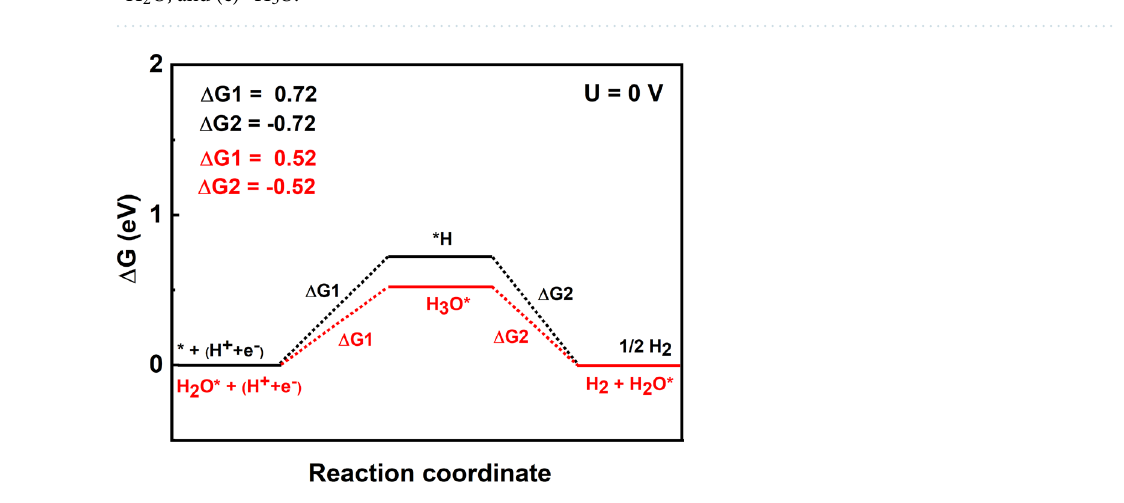
Figure 6. Calculated free energy changes of two suggested hydrogen evolution reaction; via H* formation (in black), or H 3 O* formation (in